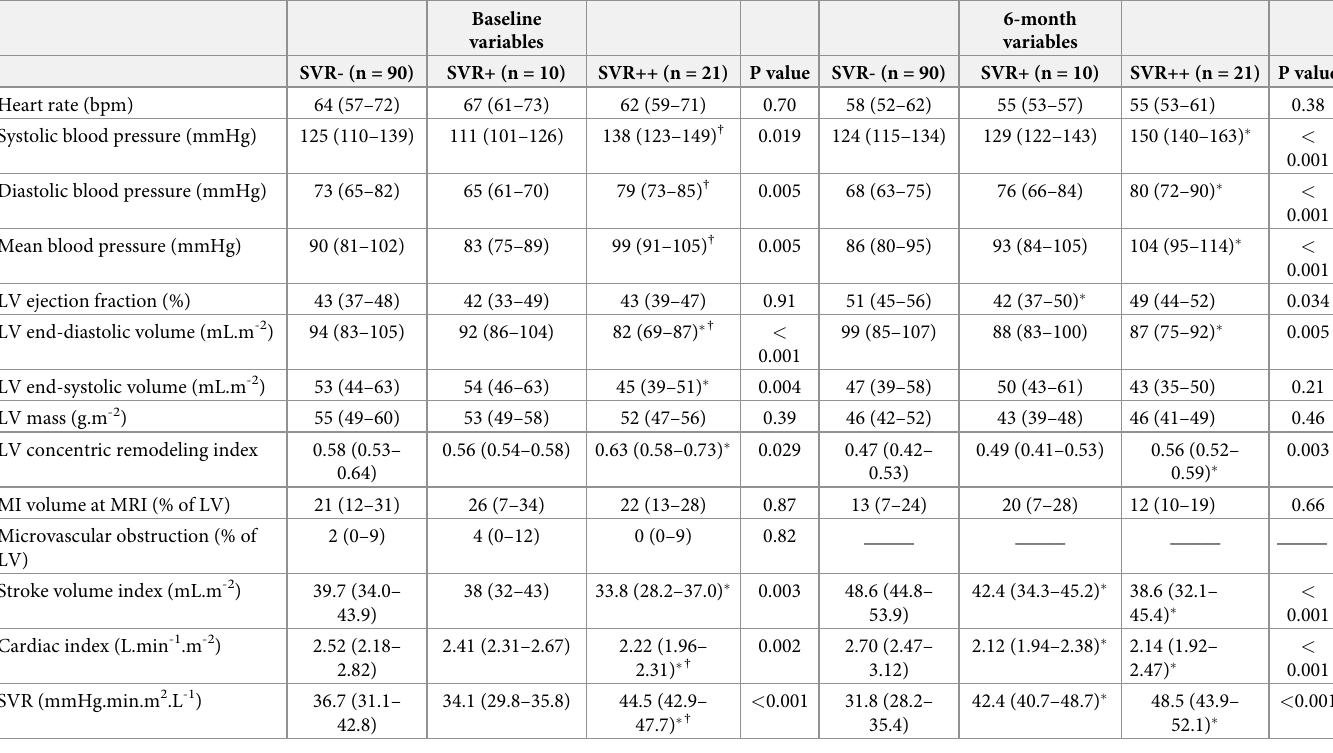
Table 2. Comparisons of hemodynamic and cardiovascular MRI variables between patients with normal SVR at 6 months (SVR-), those with abnormal SVR only at 6 months (SVR+) and those with abnormal SVR both at baseline and 6 months (SVR++). Baseline